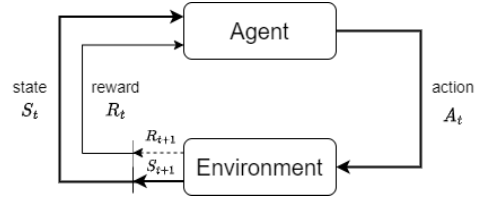
Figure 5. The agent–environment interaction in an RL decision